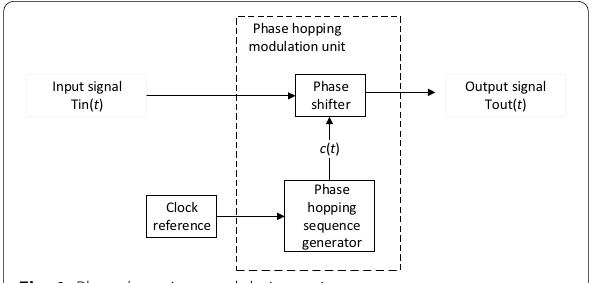
Fig. 1 Phase hopping modulation unit